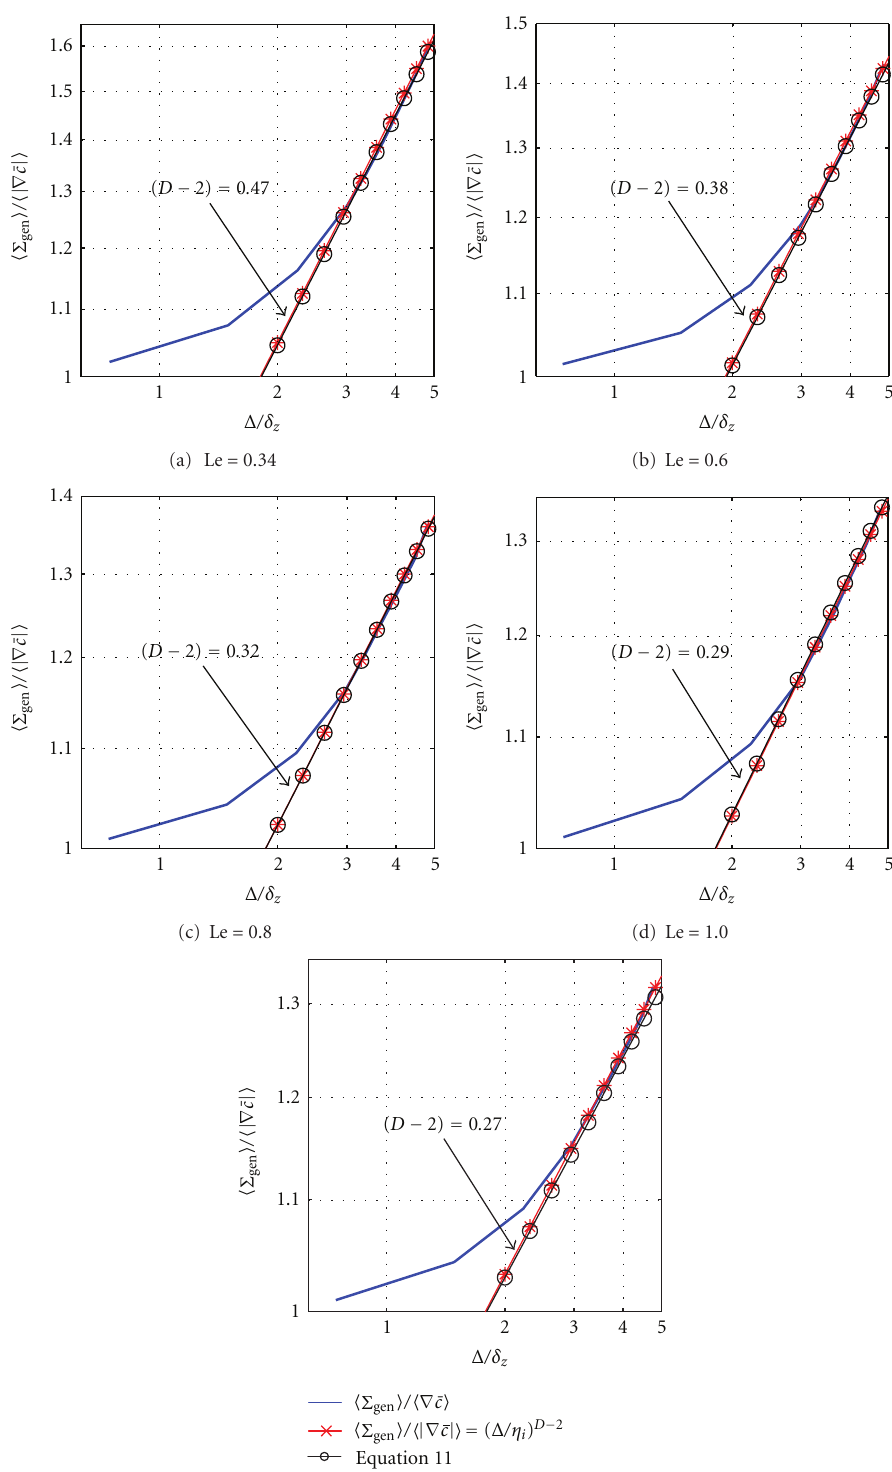
Figure 1: Variation of (cid:5) Σ gen (cid:6) / (cid:5)∇ c (cid:6) with Δ /δ z on a log-log plot for (a–e) cases A–E. Prediction of (cid:5) Σ gen (cid:6) / (cid:5)|∇ c |(cid:6) = ( Δ /η i ) D − 2 with η i obtained from DNS and ( D − 2) according to (11) is also